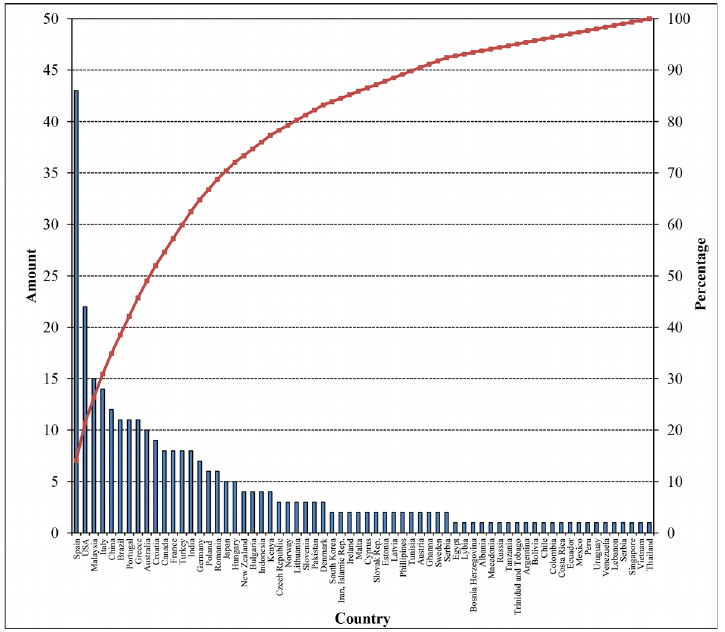
Figure 3. Country of origin of authors of articles with the topic circular MSC